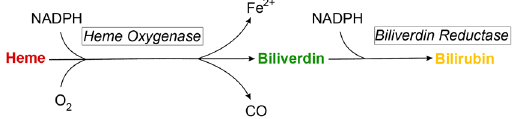
Figure 1. Schematic representation of the conversion of Heme into Bilirubin. Heme is catabolised into biliverdin by the enzyme Heme Oxygenase, releasing carbon monoxide (CO) and free iron (Fe 2 + ). Biliverdin is further reduced by Biliverdin Reductase into unconjugated bilirubin. Both enzymes depend on nicotinamide adenine dinucleotide phosphate (NADPH) as reducing